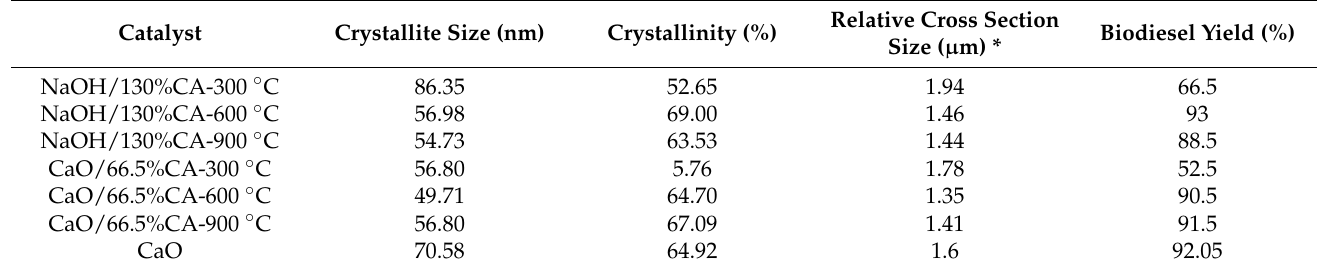
Table 2. XRD Structural properties and catalytic activity of synthesized catalysts.